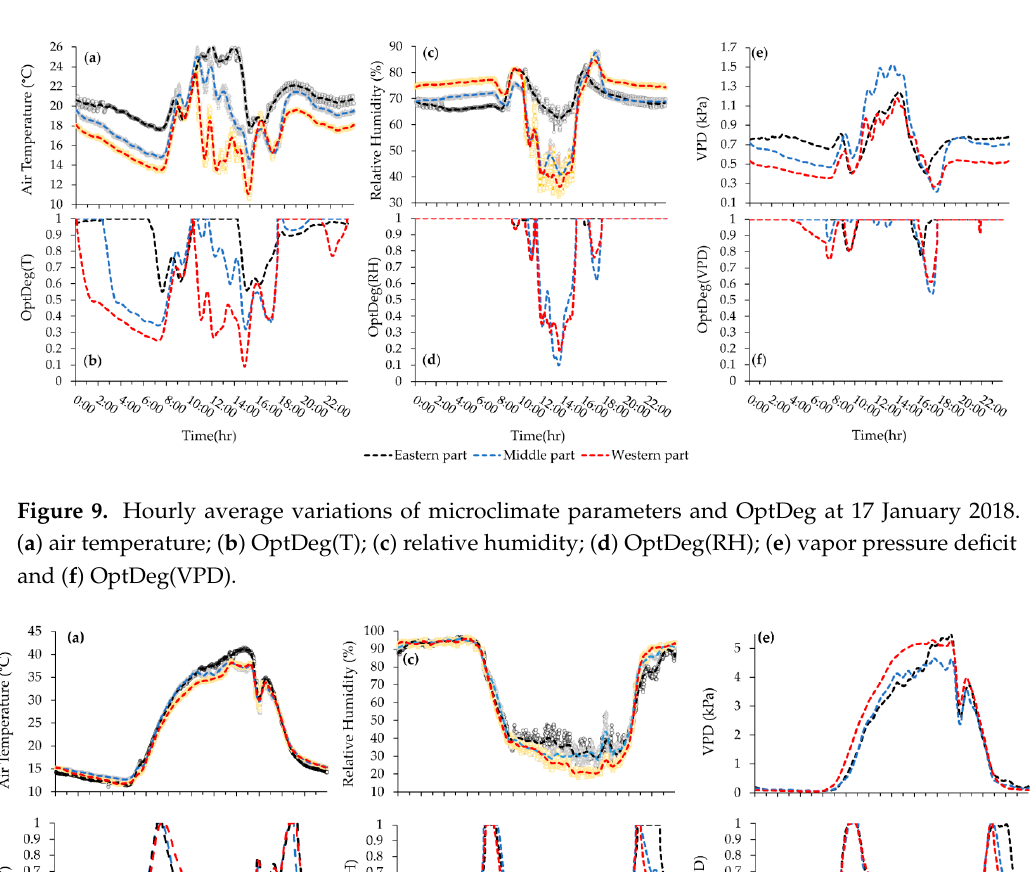
Figure 11. Hourly average variations of microclimate parameters and OptDeg at 29 July 2018. ( a ) air temperature; ( b ) OptDeg(T); ( c ) relative humidity; ( d ) OptDeg(RH); ( e ) vapor pressure deficit and ( f ) OptDeg(VPD).